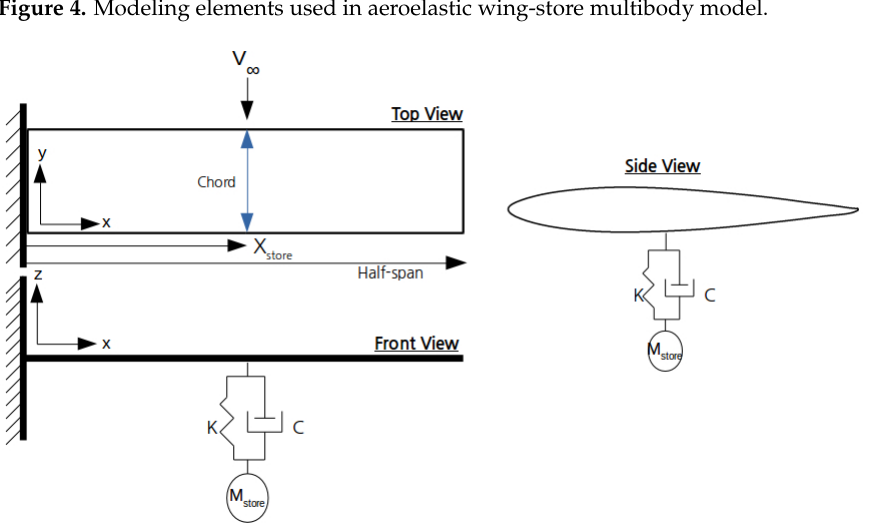
Figure 5. Store and its connection to the wing (not to